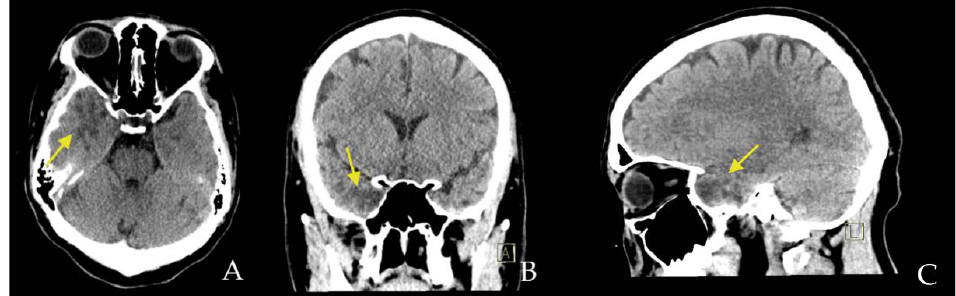
Figure 1. Brain CT in axial ( A ), coronal ( B ), and sagittal ( C ) planes reveals a hypodense area in the right temporal lobe with cortical and subcortical topography (yellow arrow), with partially lobulated contour, such as a cluster of hypodense nodules.